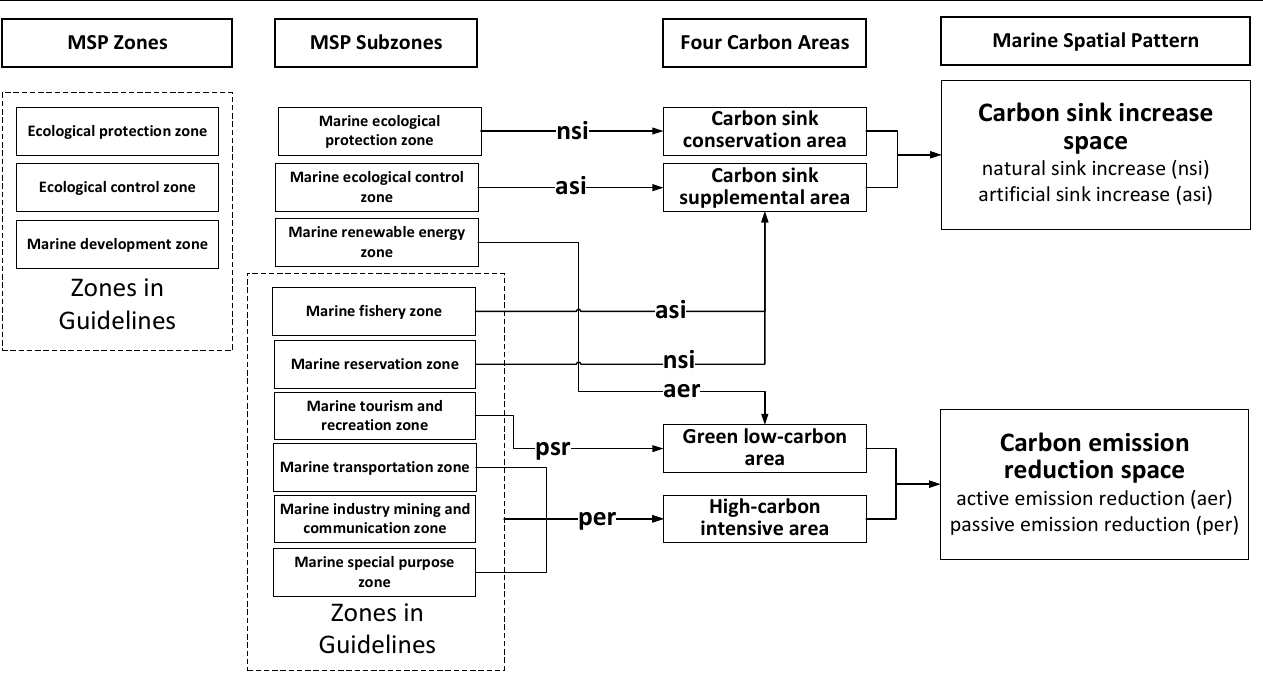
Figure 1. Marine spatial pattern for “Two Spaces and Four Carbon Areas” based on the “double carbon” goal .